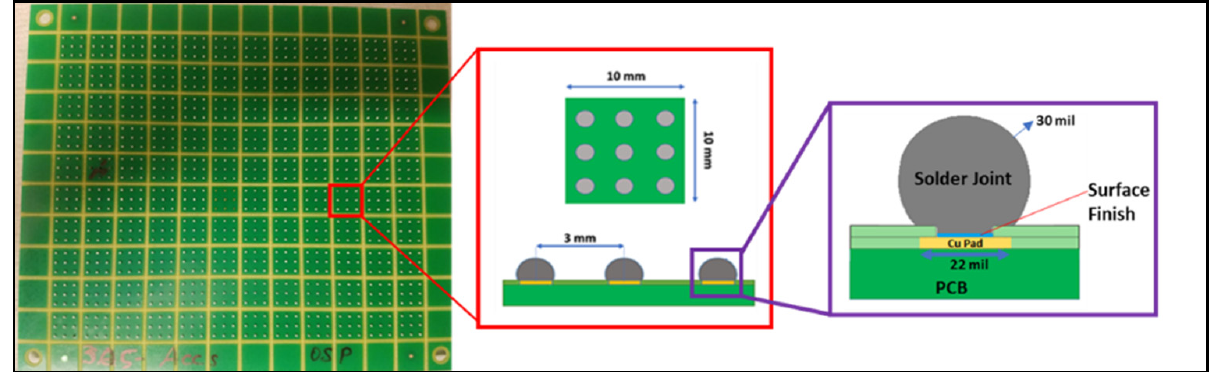
Figure 1. Test Vehicle.